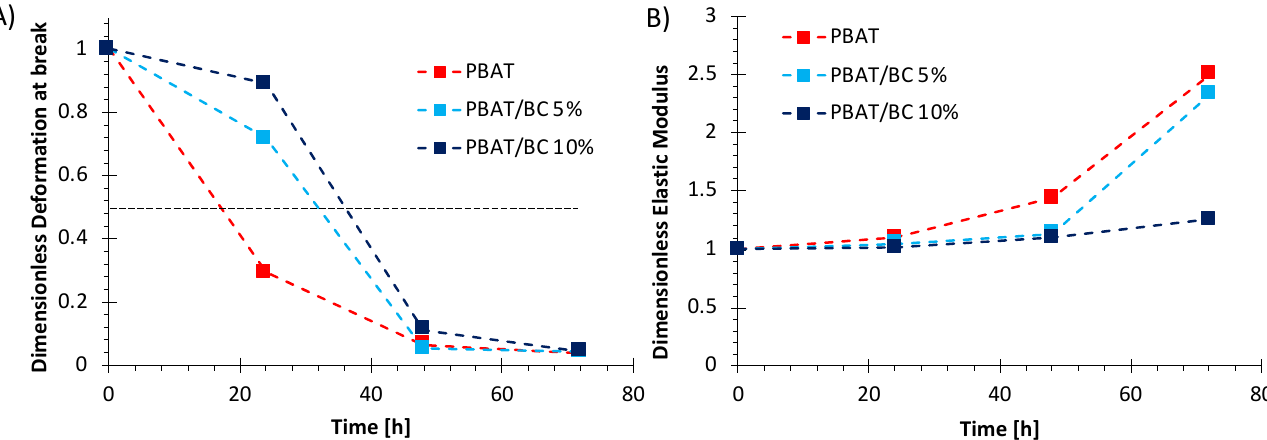
Figure 11. Dimensionless values of ( A ) deformation at break and ( B ) elastic modulus of PBAT-based blown film as a function of photo-oxidation time.